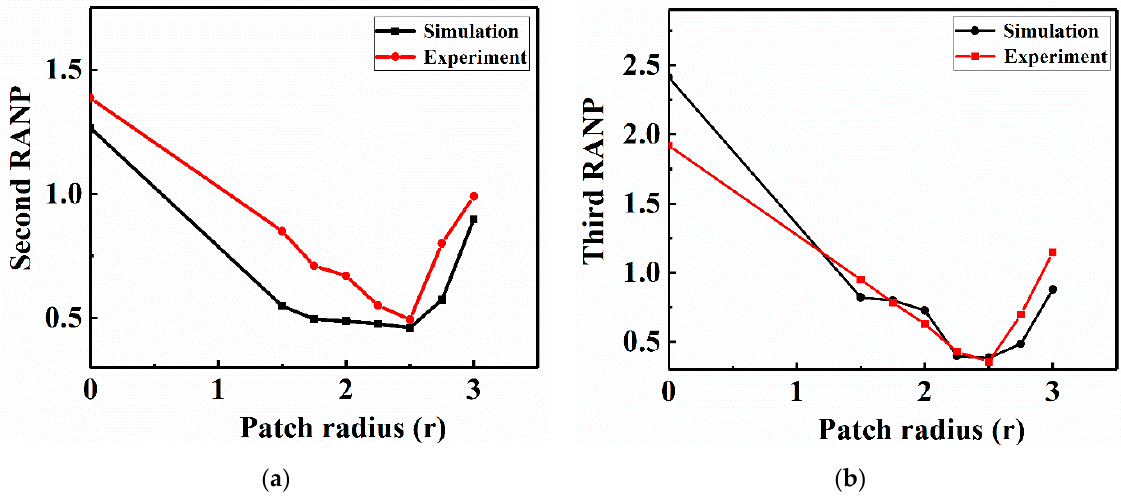
Figure 21. Numerical and experimental curves of the CFRP laminates repaired with patches of various sizes: ( a ) second RANP and ( b ) third RANP.